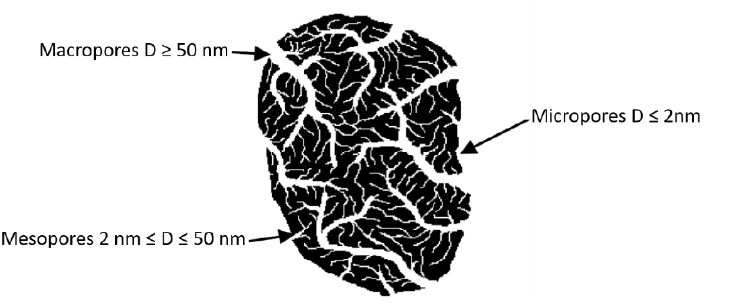
Figure 2. Schematic representation of the different types of pores. (adapted from: Muftah H. El- Naas [16]).